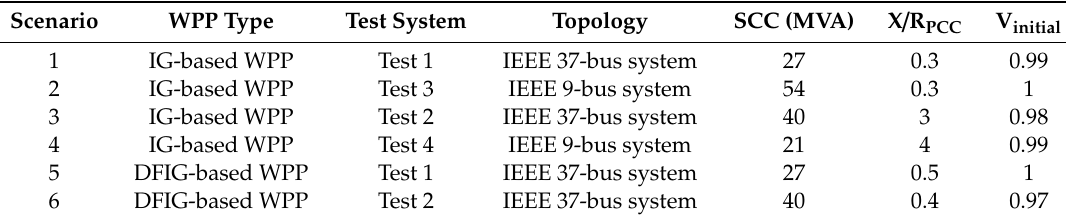
Table 12. Parameters considered for validation scenarios used in Case study 1.